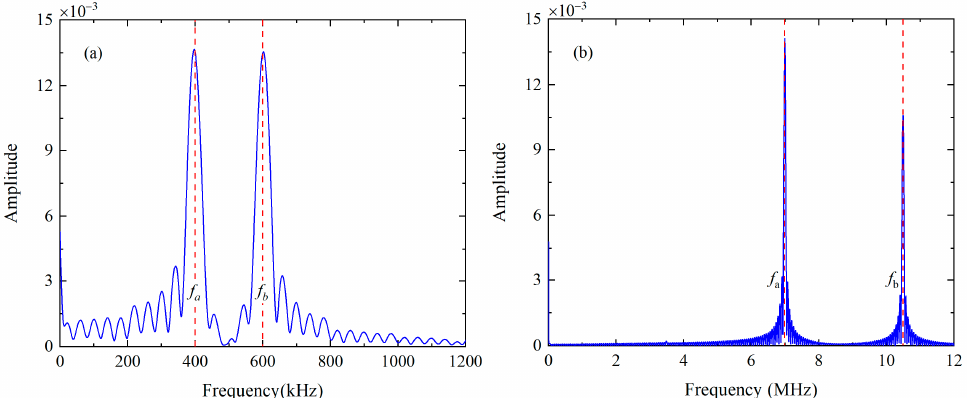
Figure 7. The excitation signals of the first ( a ) and second ( b ) mode triplet in experiments are also processed by the FFT.